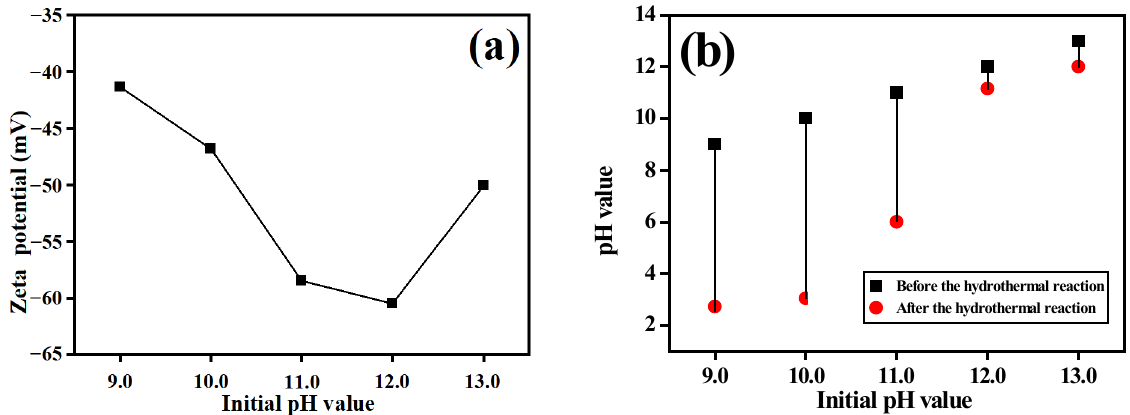
Figure 2. ( a ) Zeta potential at different pH levels. ( b ) pH changes of the solution before and after hydrothermal treatment.